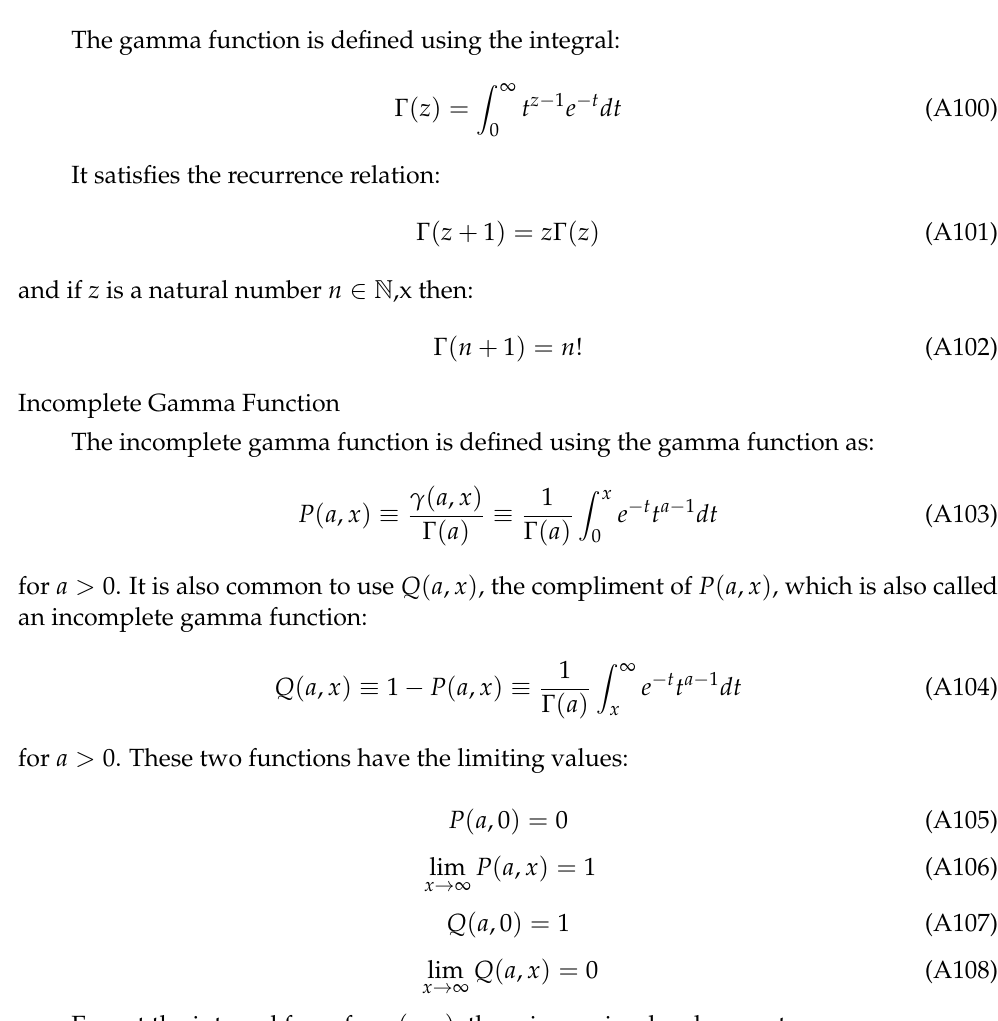
Figure A7. ( a ) Plot of the gamma function along the real axis. Adapted from: [104]. ( b ) Plot of the error function. Adapted from: